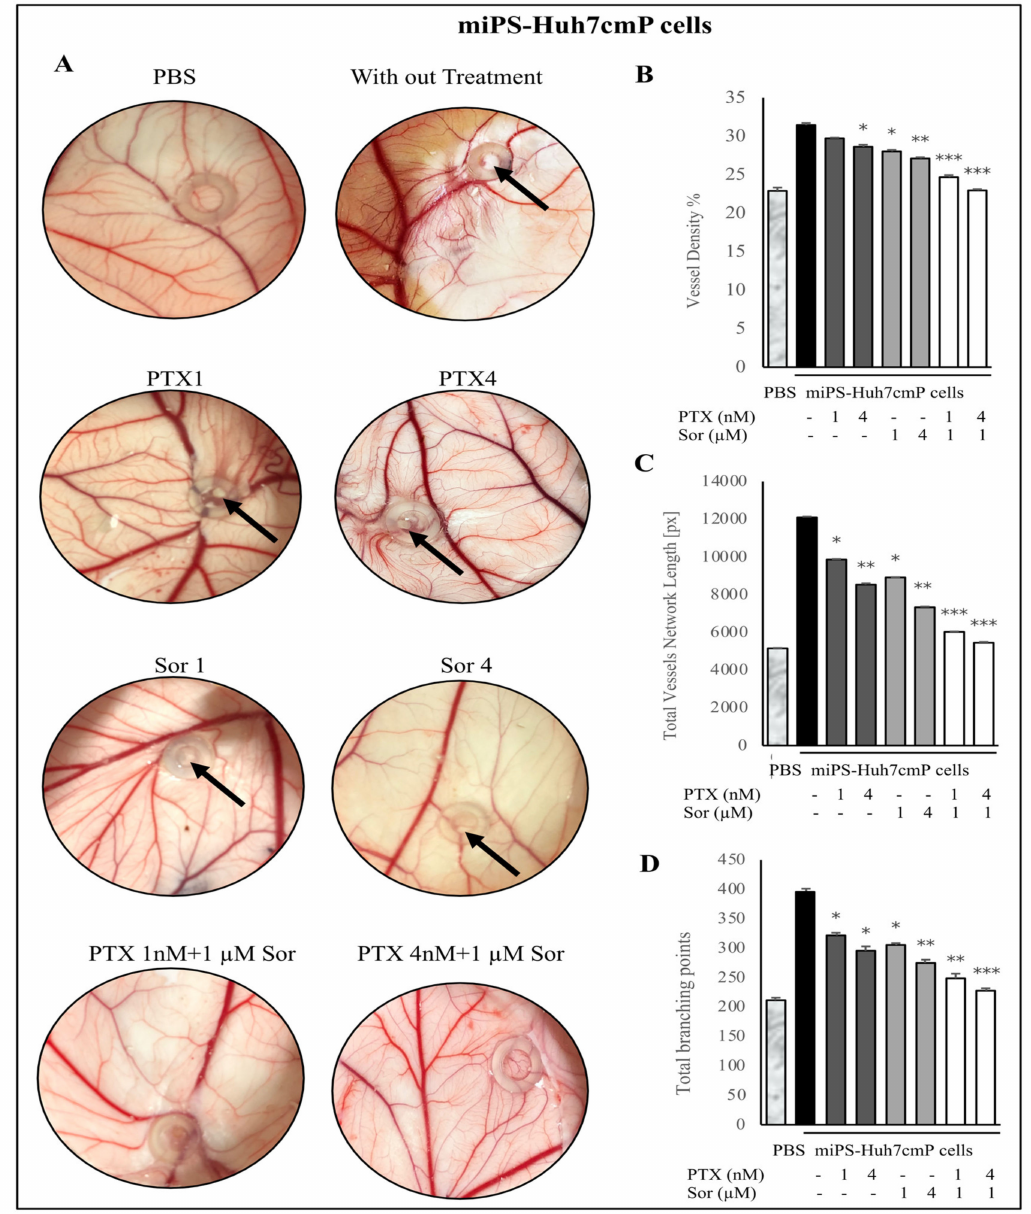
Figure 7. In vivo CAM assay. ( A ) Macroscopic observations of the antiangiogenic e ff ect of combined treatment of PTX and Sor on miPS-Huh7cmP cells. Numerous allantoic vessels converge radially around non-treated controls. Following combined treatment with PTX and Sor, evident reduction in neovessel formation compared with single treatment groups. In addition, inhibition of tumor formation was found in combined groups compared with single treatment groups (black arrow). ( B – D ) Analysis of photographs from ( A ) of the vessel density ( B ), total vessel length ( C ), and number of branching points of the vessels ( D ) of the CAM illustrating the anti-angiogenic e ff ect of single or combined treatment of PTX and Sor of miPS-Huh7cmP